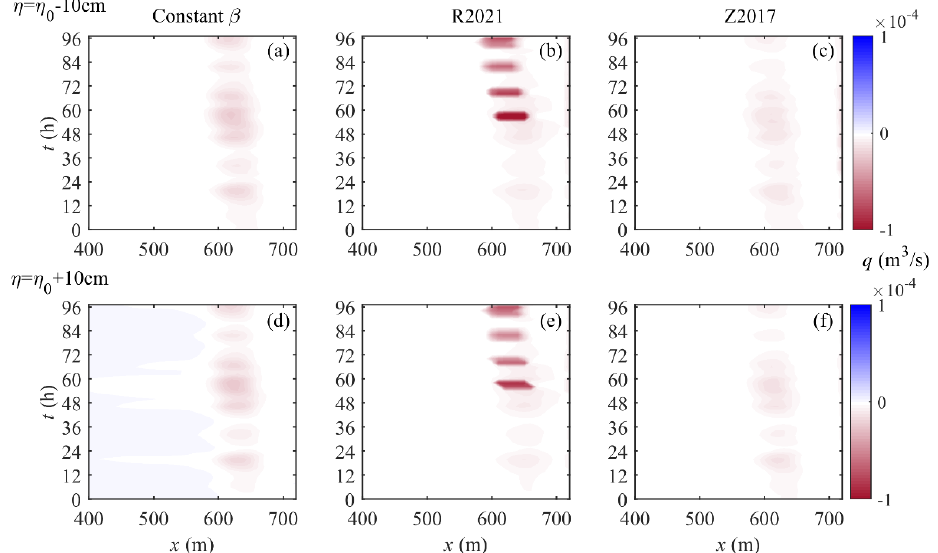
Figure 13. Spatial–temporal evolution of the suspended sediment transport rate predicted by constant roller slope (a, d) and the roller slope of R2021 (b, e) and Z2017 (c, f) under two different sea levels. Figures 13a,b,c are calculated with η 0 -10 cm, and figures 13d,e,f are calculated with η 0 +10 cm.